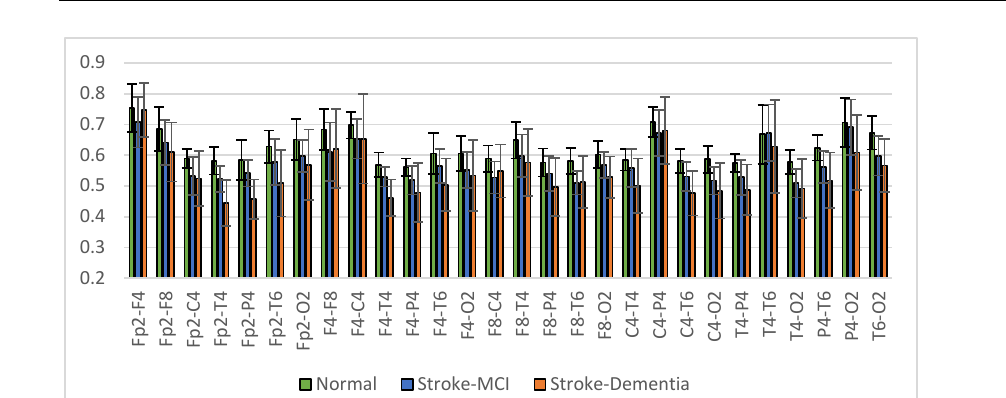
16 depicts the mean left intrahemispheric coherence for each electrode pair. Significant differences with p < 0.05 are shown in Table 7.